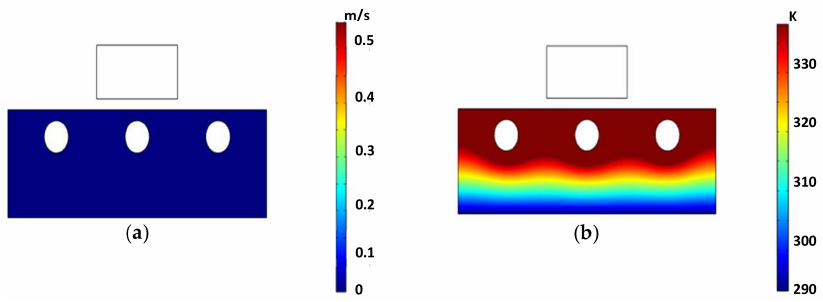
Figure 5. Contours of the reference model: ( a ) velocity contour, ( b ) temperature